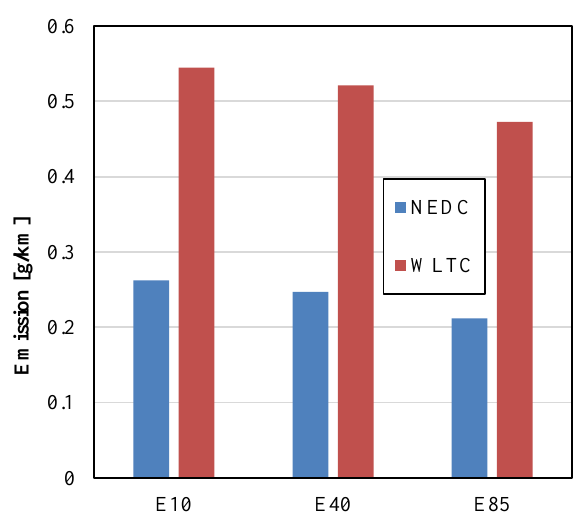
Fig. 5. CO emission values from a vehicle with a SI engine powered by E10, E40 and E85 fuel in the NEDC and WLTC test cycle